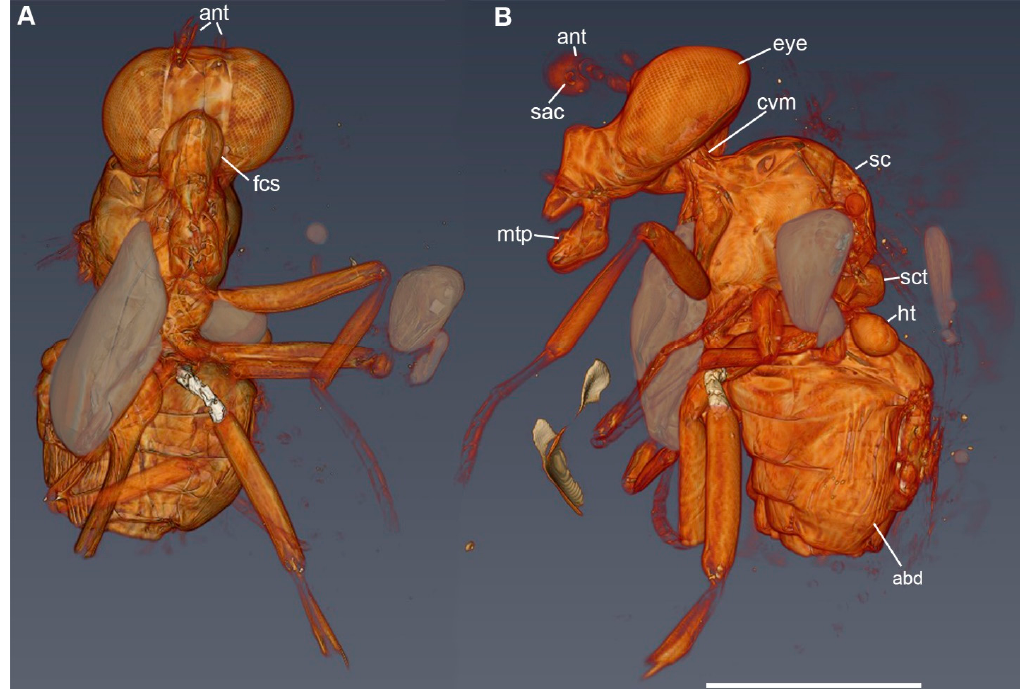
Figure 3. Lebambromyia sacculifera sp. nov., holotype, BA02-14122, 3D rendering of XPCT image. Embedded air bubbles in grey. ( A ) ventral view; ( B ) lateral view. Abbreviations: abd, abdomen; ant, antenna; cvm, cervical membrane; eye, compound eye; fcs, frontoclypeal suture; mtp, mouthparts; ht, haltere; sac, sacculus; sc, scutum; sct, scutellum. Scale bar: 1 mm. Thorax. Scutum and scutellum both strongly convex (Figures 1 and 3B). Prothoracic spiracle long, elliptical. Postpronotum narrow and projecting forward. Notopleuron with 3 robust setae (Figure 1B). Dorsal surface of scutum with short, thin setae. Scutum with slightly differentiated dorsocentral setae; supralar seta absent (Figure 1B). Pleural sclerites bare. Scutellum with apical and lateral setae. Wing. Membrane with microtrichia (Figure 2C). Vein Sc very close to vein R 1 but not fused to it; Sc and R 1 mostly run subparallel and diverge apically (note: the wing membrane between Sc and R is folded, so that the two veins seem fused on basal two thirds, Figure 2C). Membrane between apical third of veins Sc and R 1 slightly sclerotized, darker in color (Figure 2C). Vein Rs originating at height of crossvein h. Veins R 2 + 3 and R 4 + 5 almost straight. Distance between crossvein r-m and R 2 + 3 and R 4 + 5 fork more than 3 times length of r-m. Cell dm relatively long. Crossvein dm-cu perpendicular to M 1 + 2 . Cell cup relatively short, extending slightly beyond cell bm and ending well before wing margin (Figure 2C). Legs. Relatively thin, without tarsal modifi- cations. Abdomen. Tergites 1 and 2 appear at least partly fused. Female terminalia with tele- scoping elements, cerci flattened, rounded at apex (Figure 2D). Remarks. Lebambromyia sacculifera differs from L. acrai mainly in the morphology of antenna and mouthparts. The new species is characterized by a broad postpedicel pro- vided with a dorsal projection, covering the apex of pedicel, and a relatively large ventral lobe (Figure 2A,B). On the contrary, L. acrai is provided with a cordate postpedicel, with- out a dorsal projection and with a comparatively smaller ventral lobe. Lebambromyia sac- culifera is characterized by a prominent lower facial margin and well-developed mouth- parts, with rounded labial palp (Figure 2A). In contrast, Lebambromyia acrai has a short, not projecting, lower facial margin and vestigial mouthparts, but it is still provided with